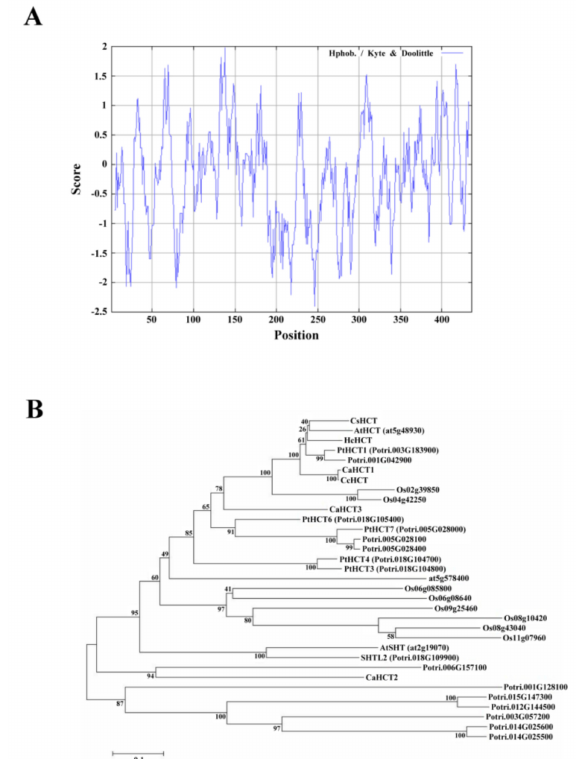
Figure 2. Hydropathy plot and phylogenetic tree analysis for CsHCT. ( A ) Hydropathy plot of CsHCT using the Kyte–Doolittle method with a window size of 436 amino acids. The window position values indicated on the x-axis of the graph reveal the average hydropathy of the entire window, with the corresponding amino acids as the middle element of that window. Plots above 0 (zero) in the graph indicate hydrophobic regions in the protein, and those below 0 (zero) indicate hydrophilic regions. ( B ) Unrooted phylogram of members of the HCT protein family. Phylogenetic tree of AtSHT (at2g19070), AtHCT (at5g48930), and HXXXD-type acyl transferase family protein (at5g57840) proteins in Arabidopsis ; transferase family protein (Os02g39850; Os04g42250; Os06g08580;